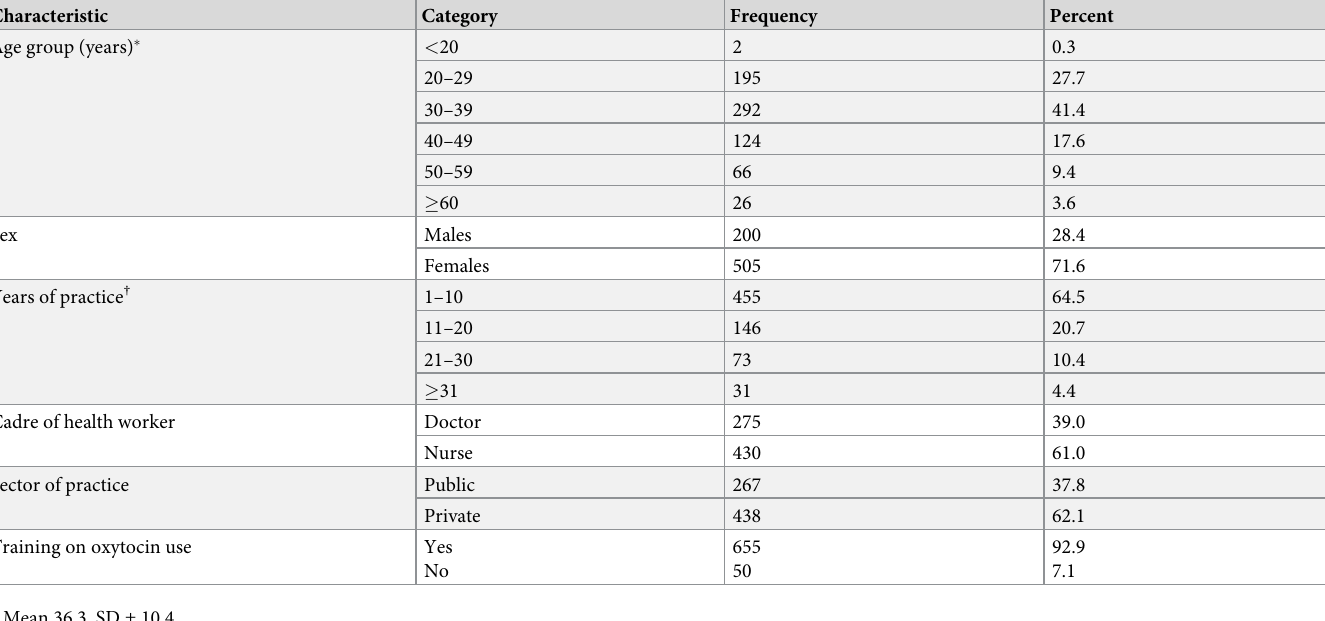
Table 2. Sociodemographic characteristics of respondents ( n = 705).